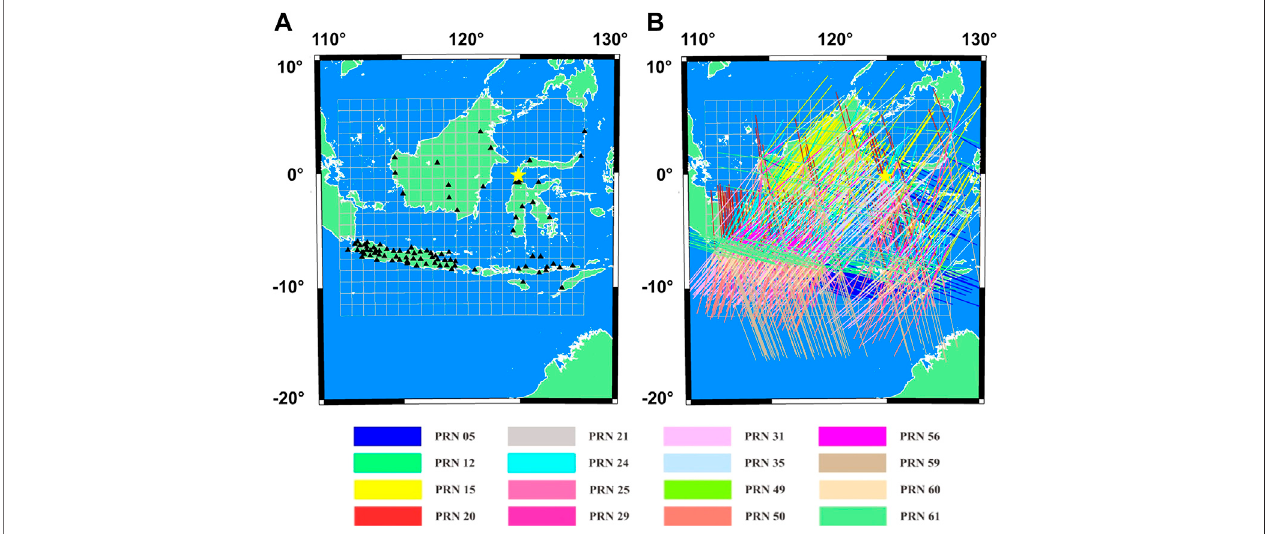
FIGURE 1 | (A) The distributions of GNSS stations from InaCORS (black triangle) used in the 2018 Palu Earthquake. The yellow star marks the epicenter of the 2018Paluearthquakewithamagnitudeof7.5Mwthatoccurredat10:02:44UT. (B) Thedistribution ofLoSovertheareablockstomographywithdifferentcoloredlines used to represent each on the